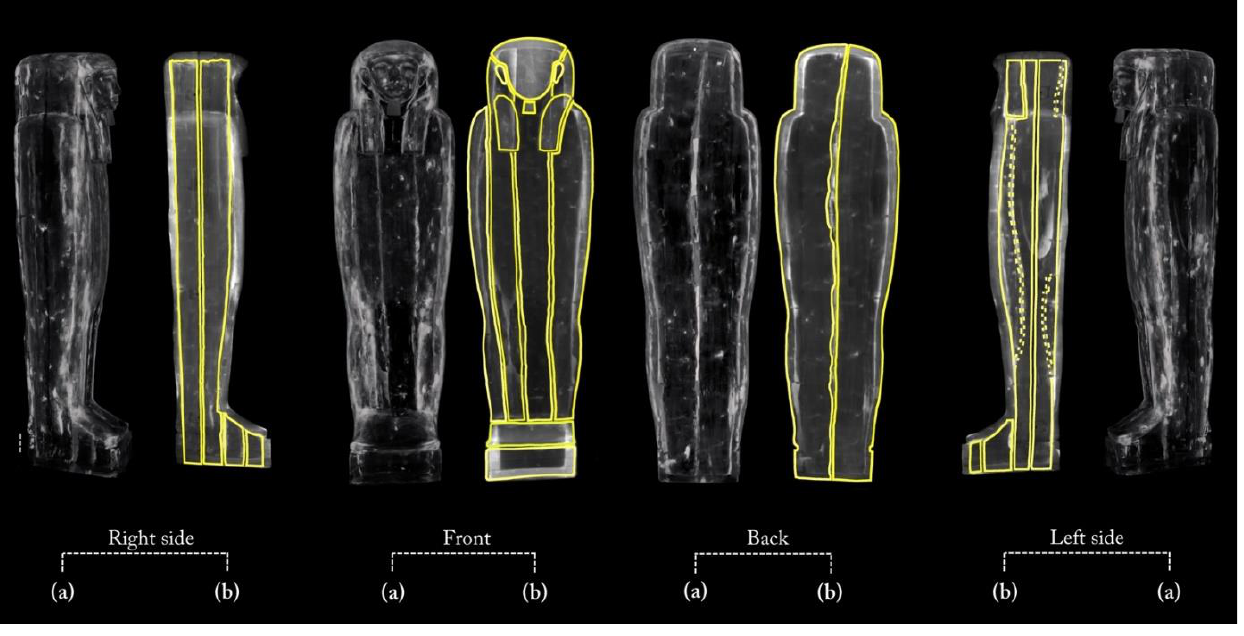
Figure 5. ( a ) 3D rendering of the sides of Un-Montu’s coffin and ( b ) visualization of its planks on each side.